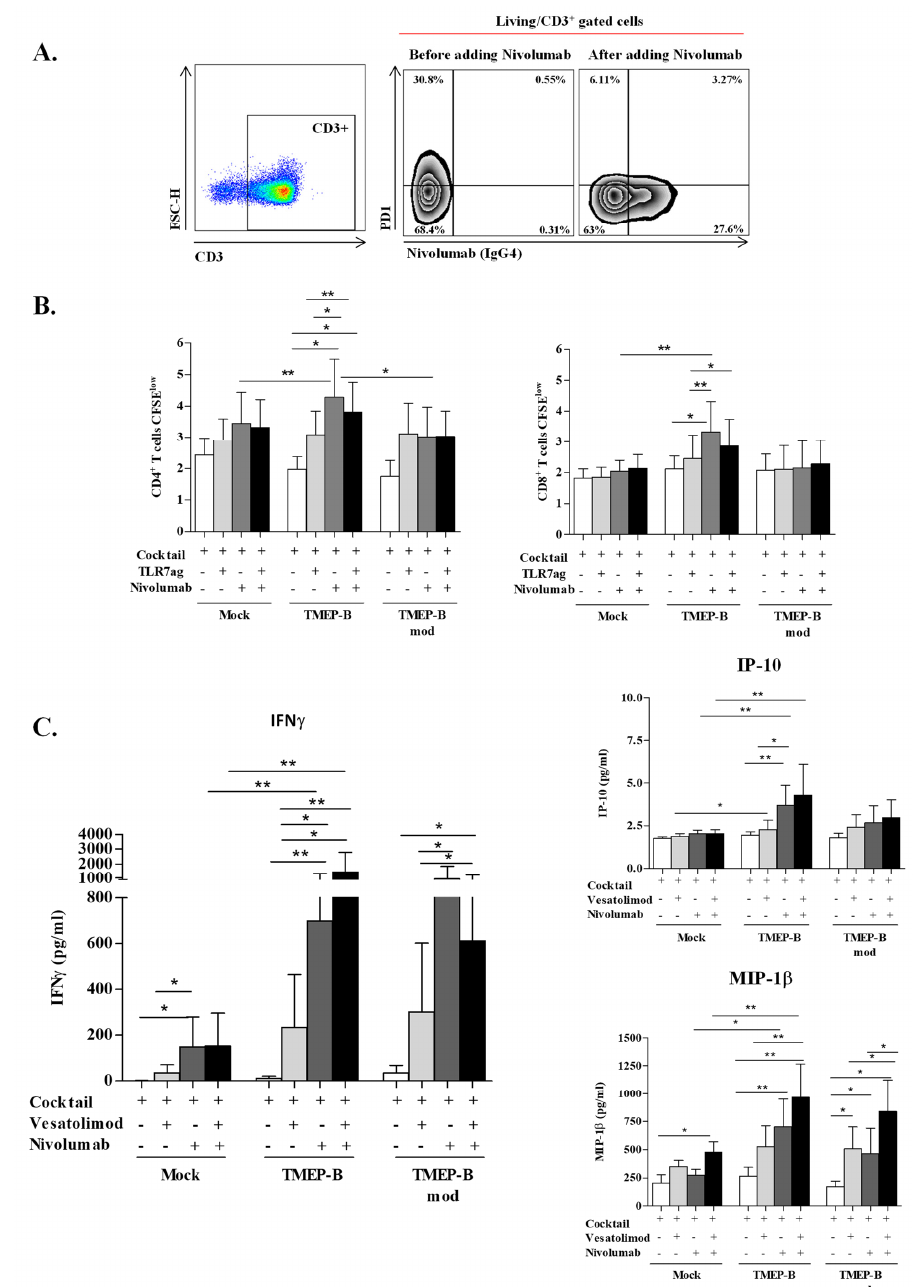
Figure 5. HIV-specific T-cell proliferation and cytokine secretion with or without vesatolimod or nivolumab. ( A ) Analysis of PD1 expression by flow cytometry using T-cells from HIV infected patients and a specific anti-PD1 antibody (EH12.1) with or without Nivolumab (20 µ g/mL). ( B ) Analysis of T-cell proliferation (CD3+ CD4+ and CD3+ CD8+) in co-cultures using DCs electroporated with TMEP-B or TMEP-Bmod and adding only cocktail cytokines or in combination with nivolumab (20 µ g/mL), vesatolimod (1000 nM) or both ( n = 8). ( C ) Analysis of cytokine secretion (IFN γ , IP10, MIP-1 β ) after 6 days of co-culture using DCs electroporated with TMEP-B or TMEP-Bmod ( n = 9). Mock transfected DCs were used as negative controls. Graphic shows the cytokine secretion in the following settings: cocktail added in the co-culture (white); cocktail plus 1000 nM vesatolimod (light gray); cocktail plus 20 µ g/mL nivolumab (dark gray); or cocktail plus both agents (Black). Percentages ± SD are shown. Analysis was by Wilcoxon signed rank test (* p < 0.05; ** p < 0.01; *** p <